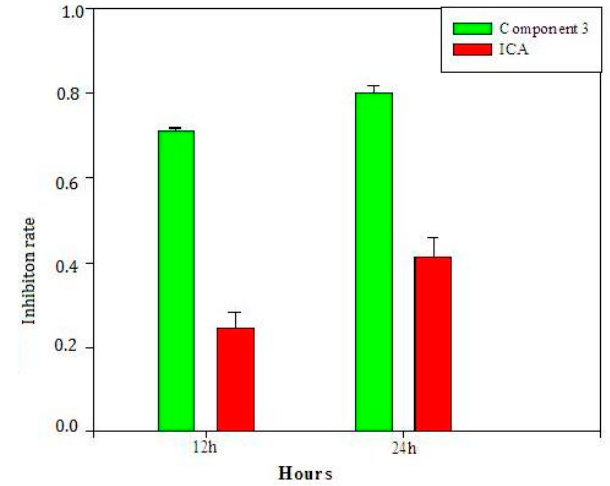
Figure 7. Comparison of activities of component 3 and icariin after 12 and 24 h incubation.